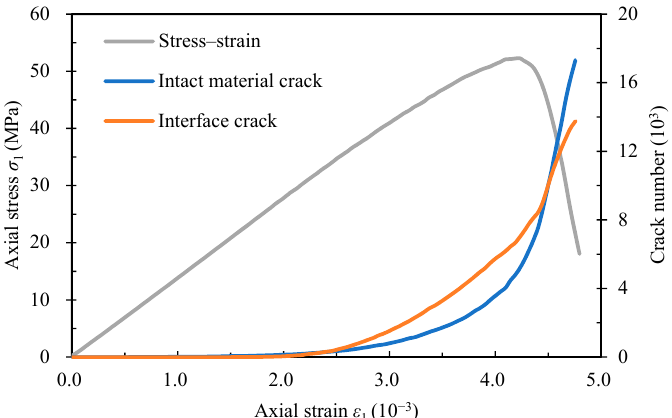
Figure 15. Evolution of crack number in transversely isotropic jointed rock models having dip angle of 90°.